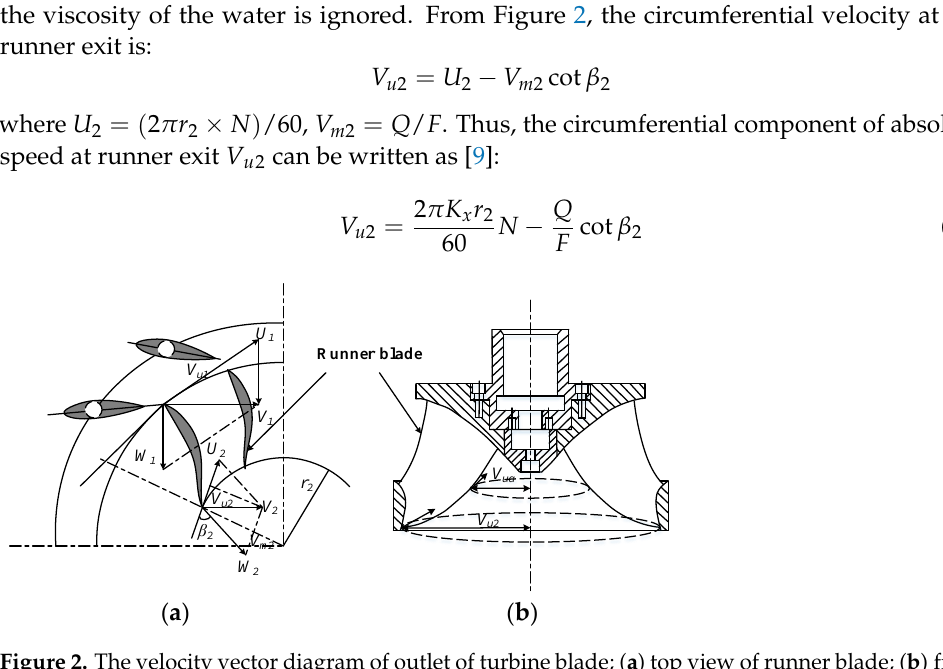
Figure 2. The velocity vector diagram of outlet of turbine blade; ( a ) top view of runner blade; ( b ) front view of runner blade.